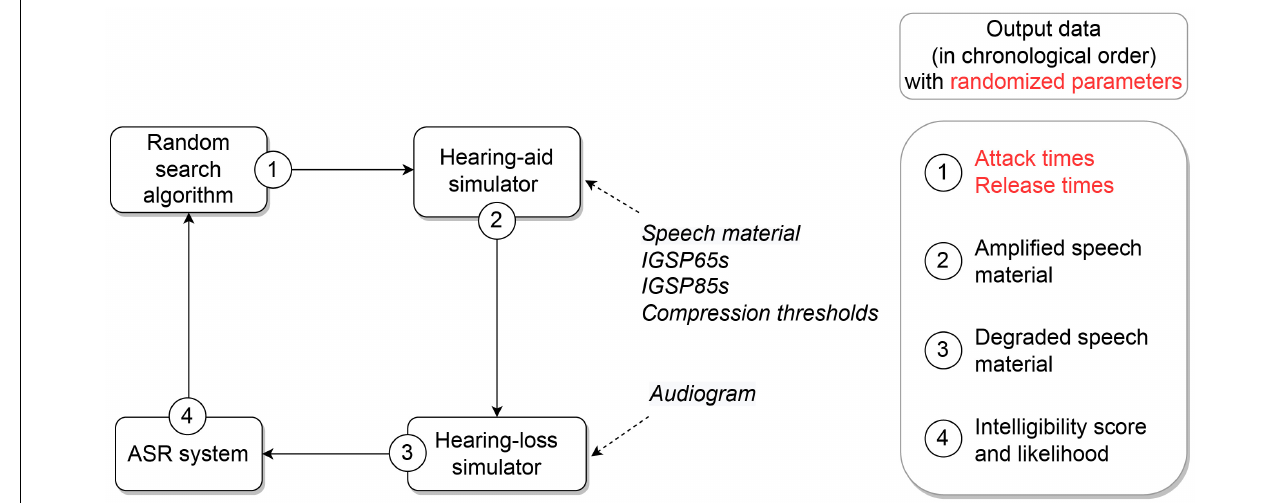
FIGURE 1 | Components of the OPRA-RS optimization chain, with associated input data (in italics) and output data (right panel). The parameters randomized by the RS algorithm are highlighted in